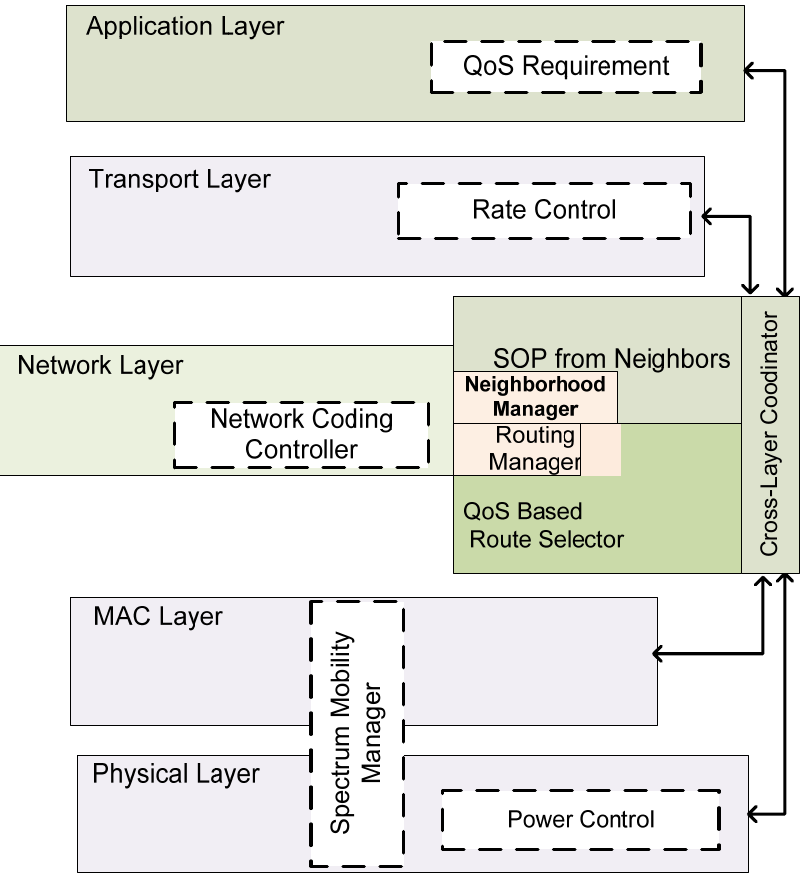
Figure 1. Cross-layer framework